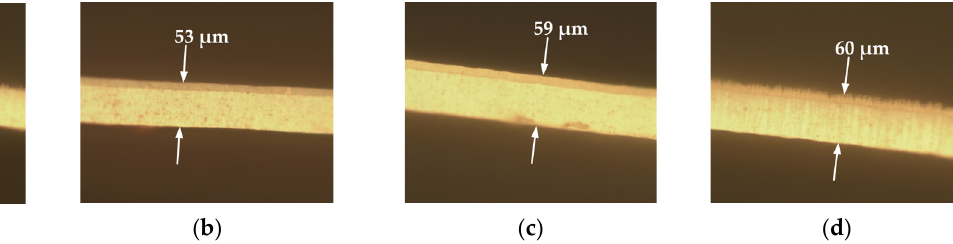
Figure 6. Images of the thickness of the AAO membrane when the membranes were fabricated under different anodization conditions: ( a ) no frequency excitation; ( b ) excitation at 20 kHz; ( c ) excitation at 40 kHz; ( d ) resonant frequency excitation at 40 kHz.